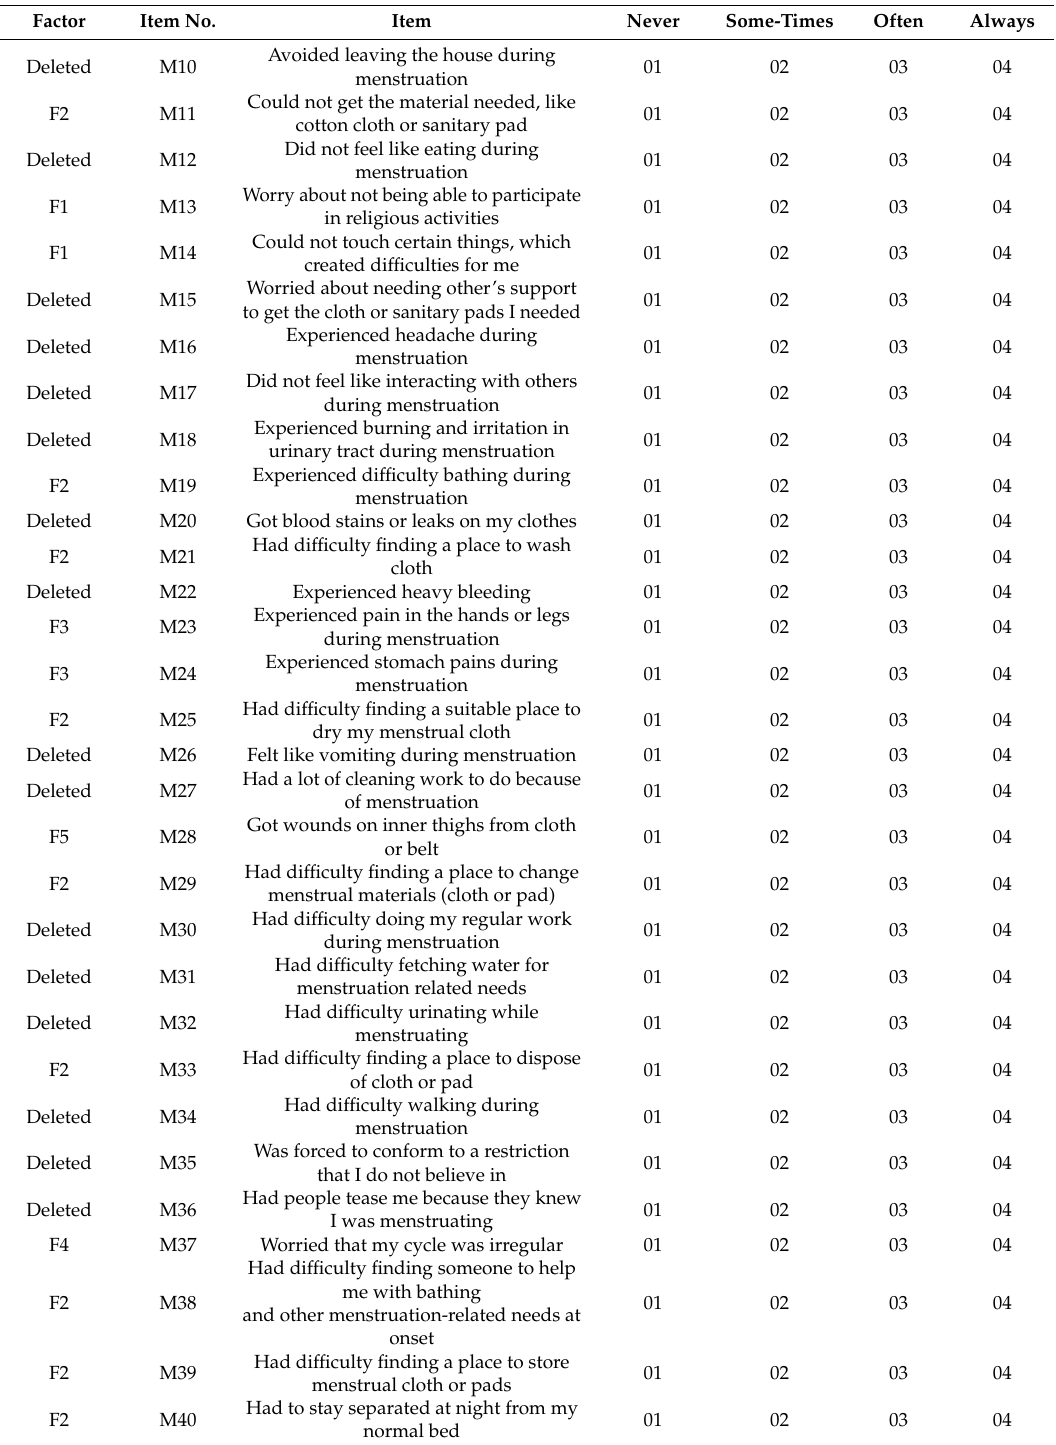
Table A1. Menstrual Insecurity